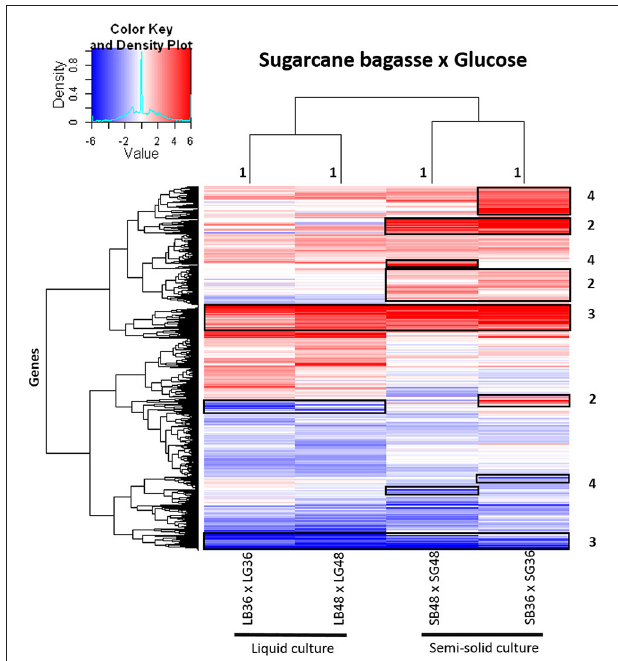
FIGURE 3 | Heatmap of hierarchical clustering of gene transcript modulation patterns observed in A. tamarii BLU37 following growth on SB in comparison to glucose as carbon source. Gene transcripts were compared between growth treatments LB36 and LG36, LB48 and LG48, SB36 and SG36, and SB48 and SG48 (padj < 0.01). All log 2 FoldChange values below − 6 or above 6 were considered as minimum and maximum values. Categorized groupings of expressed genes one to four are referred to in the main text of the